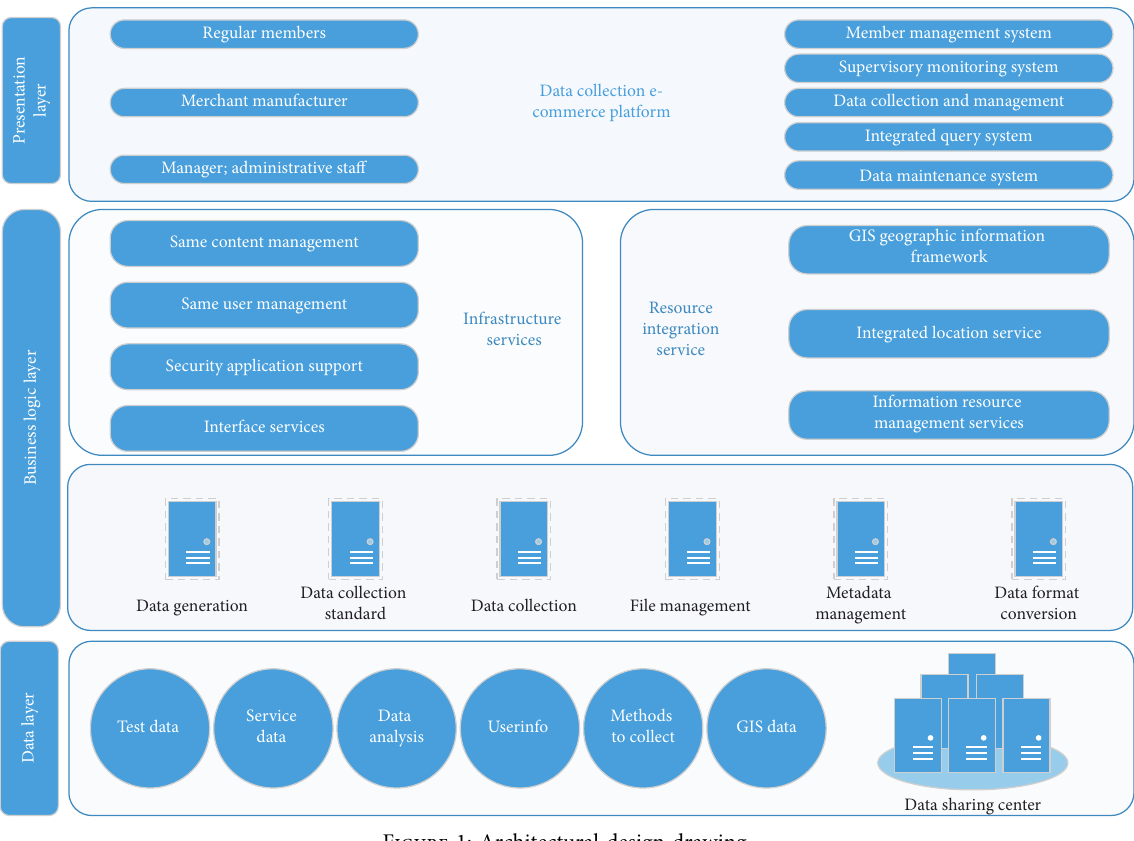
Figure 1: Architectural design drawing.